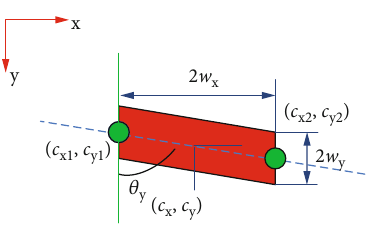
Figure 4: The surface of volume source is not parallel to the reservoir boundaries.